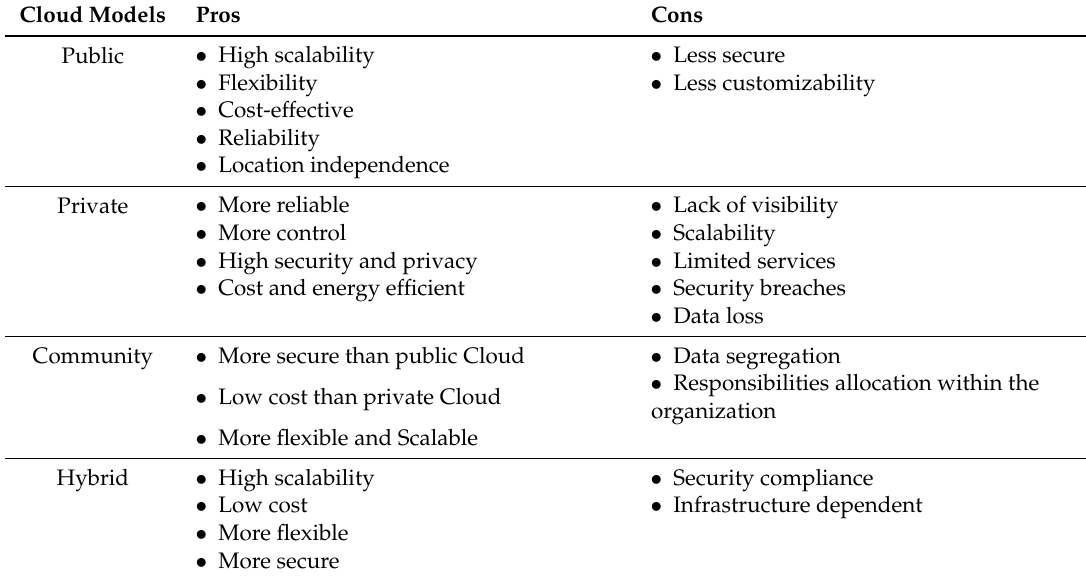
Table 2. Comparative analysis of the cloud deployment